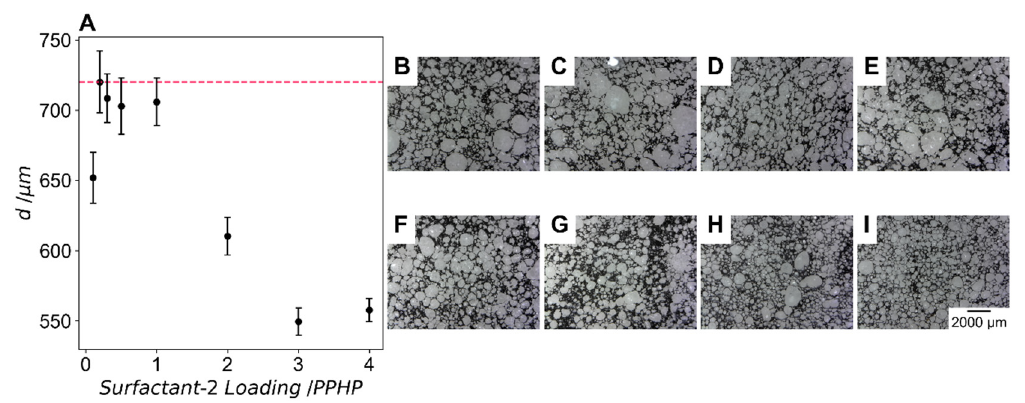
Figure 7. ( A ) The cell size of polyurethane as a function of surfactant-2 loading with the solid line indicating an exponential fit to the data, and the error bars indicating one standard error. ( B – I ) Op- tical microscope images of the foams with stained surfaces at surfactant-2 loadings of ( B ) 0.1 PPHP, ( C ) 0.2 PPHP, ( D ) 0.3 PPHP, ( E ) 0.5 PPHP, ( F ) 1 PPHP, ( G ) 2 PPHP, ( H ) 3 PPHP and ( I ) 4